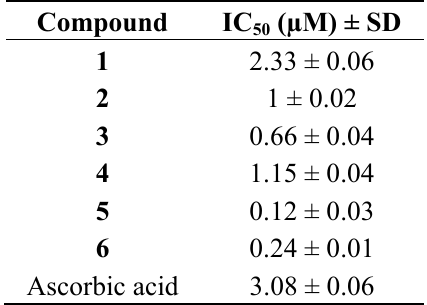
Table 3. The scavenging activity of compounds 1 – 6 on DPPH free radicals.